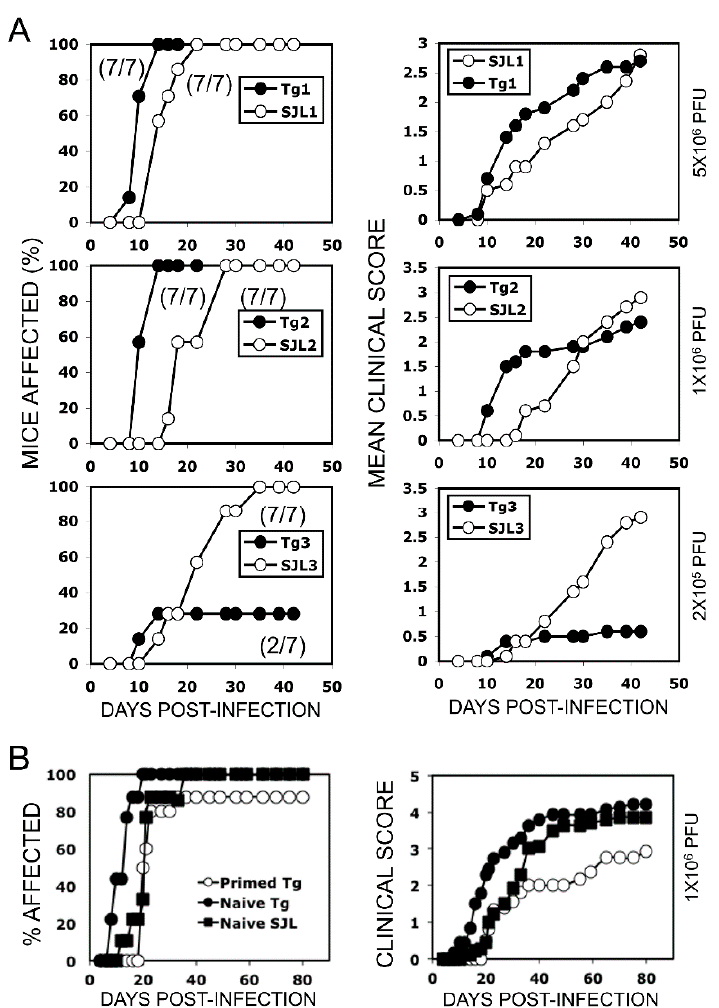
Figure 3. E ff ects of virus infection-dose and virus-reactive CD4 + T cells on the development of demyelinating disease. ( A ) Di ff erent viral doses (2 × 10 5 , 1 × 10 6 and 5 × 10 6 PFU) were used to infect SJL mice receiving VP2-TCR-Tg or control SJL CD4 + T cells to compare the development of clinical symptoms for 45 days. CD4 + T cells were purified using a negative selection column. Purified CD4 + T cells (1 × 10 6 / mouse) were injected through the tail-base vein of naive SJL mice. Recipient SJL mice ( n = 7) were infected intra-cerebrally with the indicated PFUs; 5 × 10 6 PFU (upper row), 1 × 10 6 PFU (middle row), and 2 × 10 5 PFU (bottom row). Clinical signs were scored two times per week for 50 days. The mean disease score (left column) and % of a ff ected mice (right column) are shown. The two-tailed p values between the groups were significant based on the paired t test of the mean clinical cores, with p < 0.0001 ( t = 17.080 with 7 degrees of freedom) in the upper row groups between days 10 and 35, p = 0.0219 ( t = 2.309 with 6 degrees of freedom) in the middle row groups between days 10 and 30, and p = 0.0065 ( t = 4.428 with 5 degrees of freedom) in the bottom groups between days 20 and 42. ( B ) Purified CD4 + T cells (2 × 10 6 cells / mouse) stimulated in vitro with PBS or VP2 74-86 for 6 h were transferred into naive SJL mice and then infected with TMEV (1 × 10 6 pfu / mouse). The developments of clinical symptoms were compared among these experimental groups ( n = 10) over 80 days postinfection. The two-tailed p values between the groups were significant based on a paired t test of the mean clinical cores between days 8 and 40 postinfection: p < 0.0001 ( t = 8.534 with 13 degrees of freedom) between the group receiving naive VP2-TCR-Tg CD4 + T cells and the group receiving VP2-primed VP2-TCR-Tg CD4 + T cells, p < 0.0159 ( t = 2.771 with 13 degrees of freedom) between the group with VP2-primed Tg CD4 + T cells and the group with naive SJL CD4 + T cells, and p < 0.0001 ( t = 7.389 with 13 degrees of freedom) between the group with naive VP2-TCR-Tg CD4 + T cells and the group with naive SJL CD4 + T